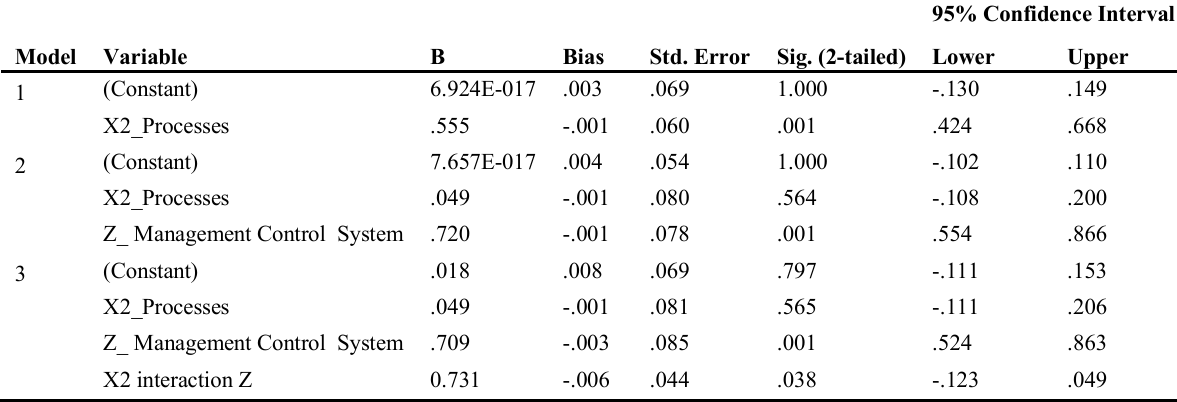
Table 8: Model coefficients; MMR model on